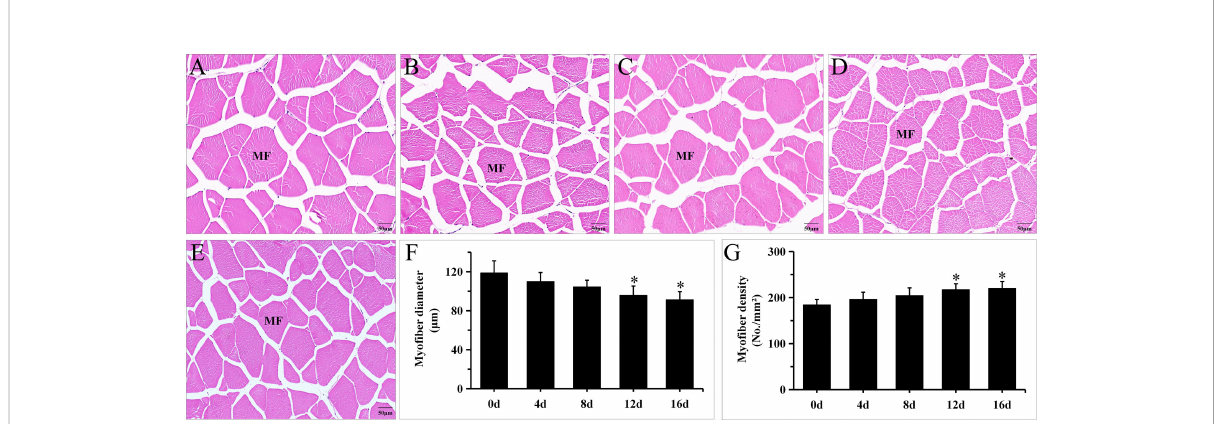
FIGURE 1 Short-term exercise induced changes in myo fi ber morphology in hybrid species. Illustrative images of cross-section of muscle in 0d (A) , 4d (B) , 8d (C) , 12d (D) and 16d (E) group of hybrid species. The effects of short-term exercise on the diameter (F) and density (G) of muscle fi ber in hybrid species (N = 15, mean ± SD). * P ≤ 0.05. MF, myo fi